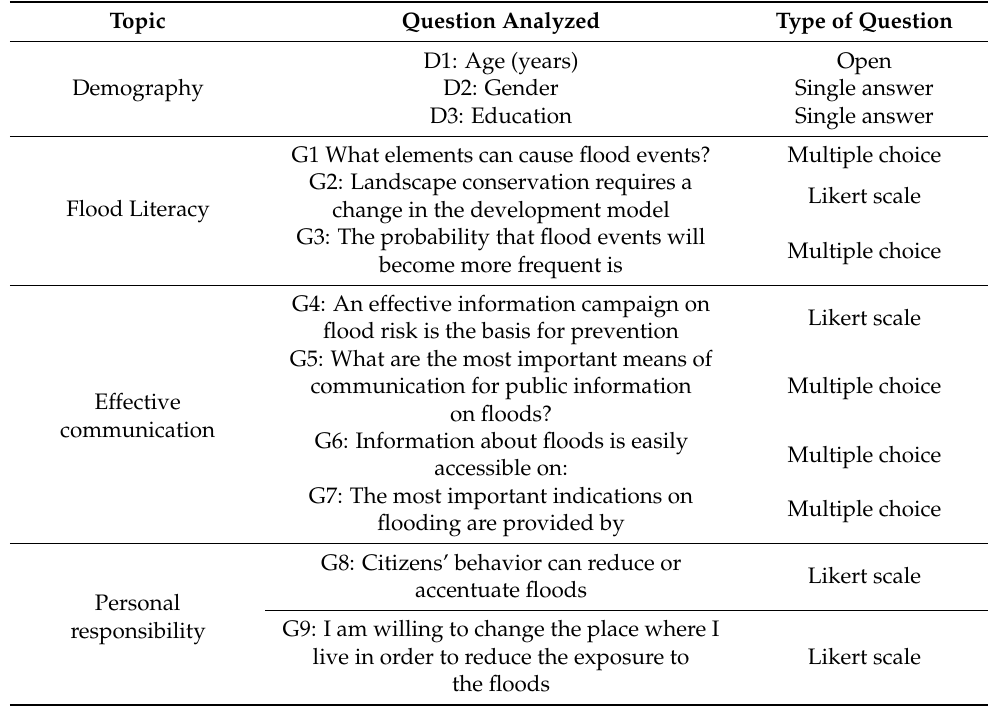
Table 2. Overview of the questions selected for the analysis with classification by thematic area and type of